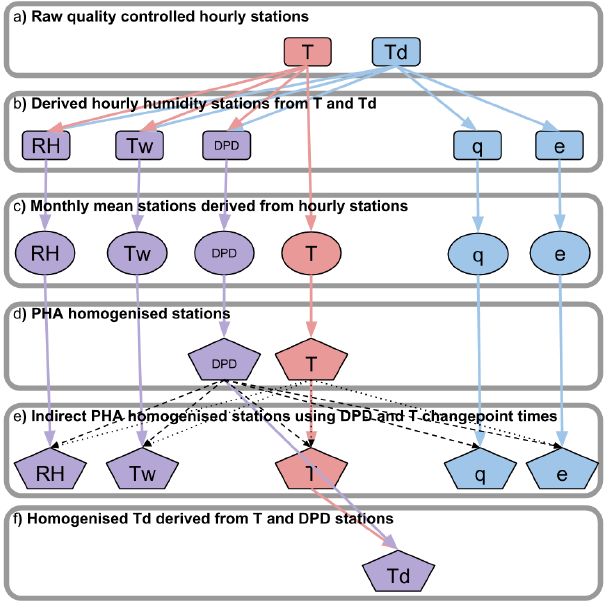
Figure 1. Flow diagram of HadISDH.2.0.0 processing from hourly quality-controlled values to monthly mean homogenised station val-